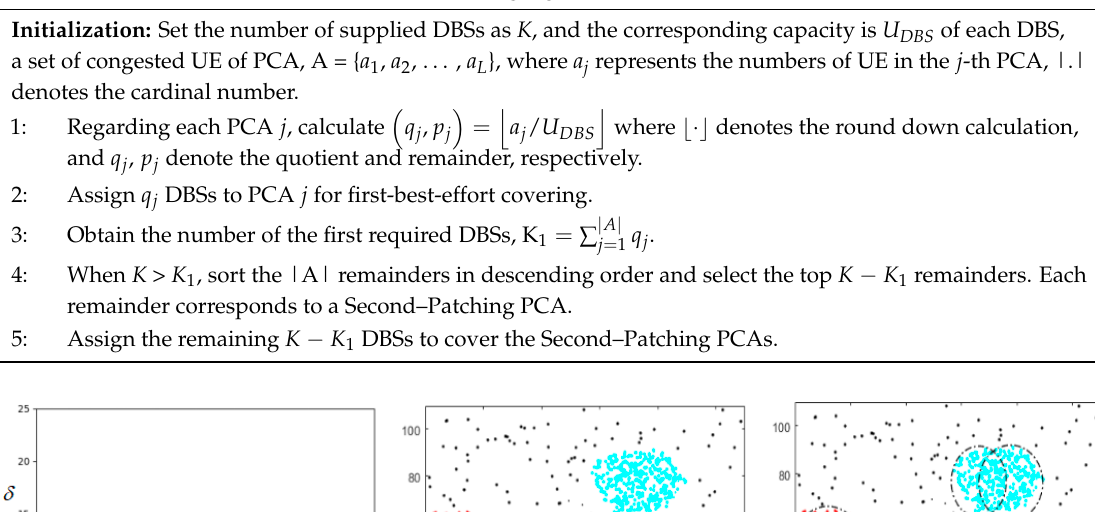
Algorithm 2 . First-Best-Effort and Second-Patching algorithm (FBE–SP)